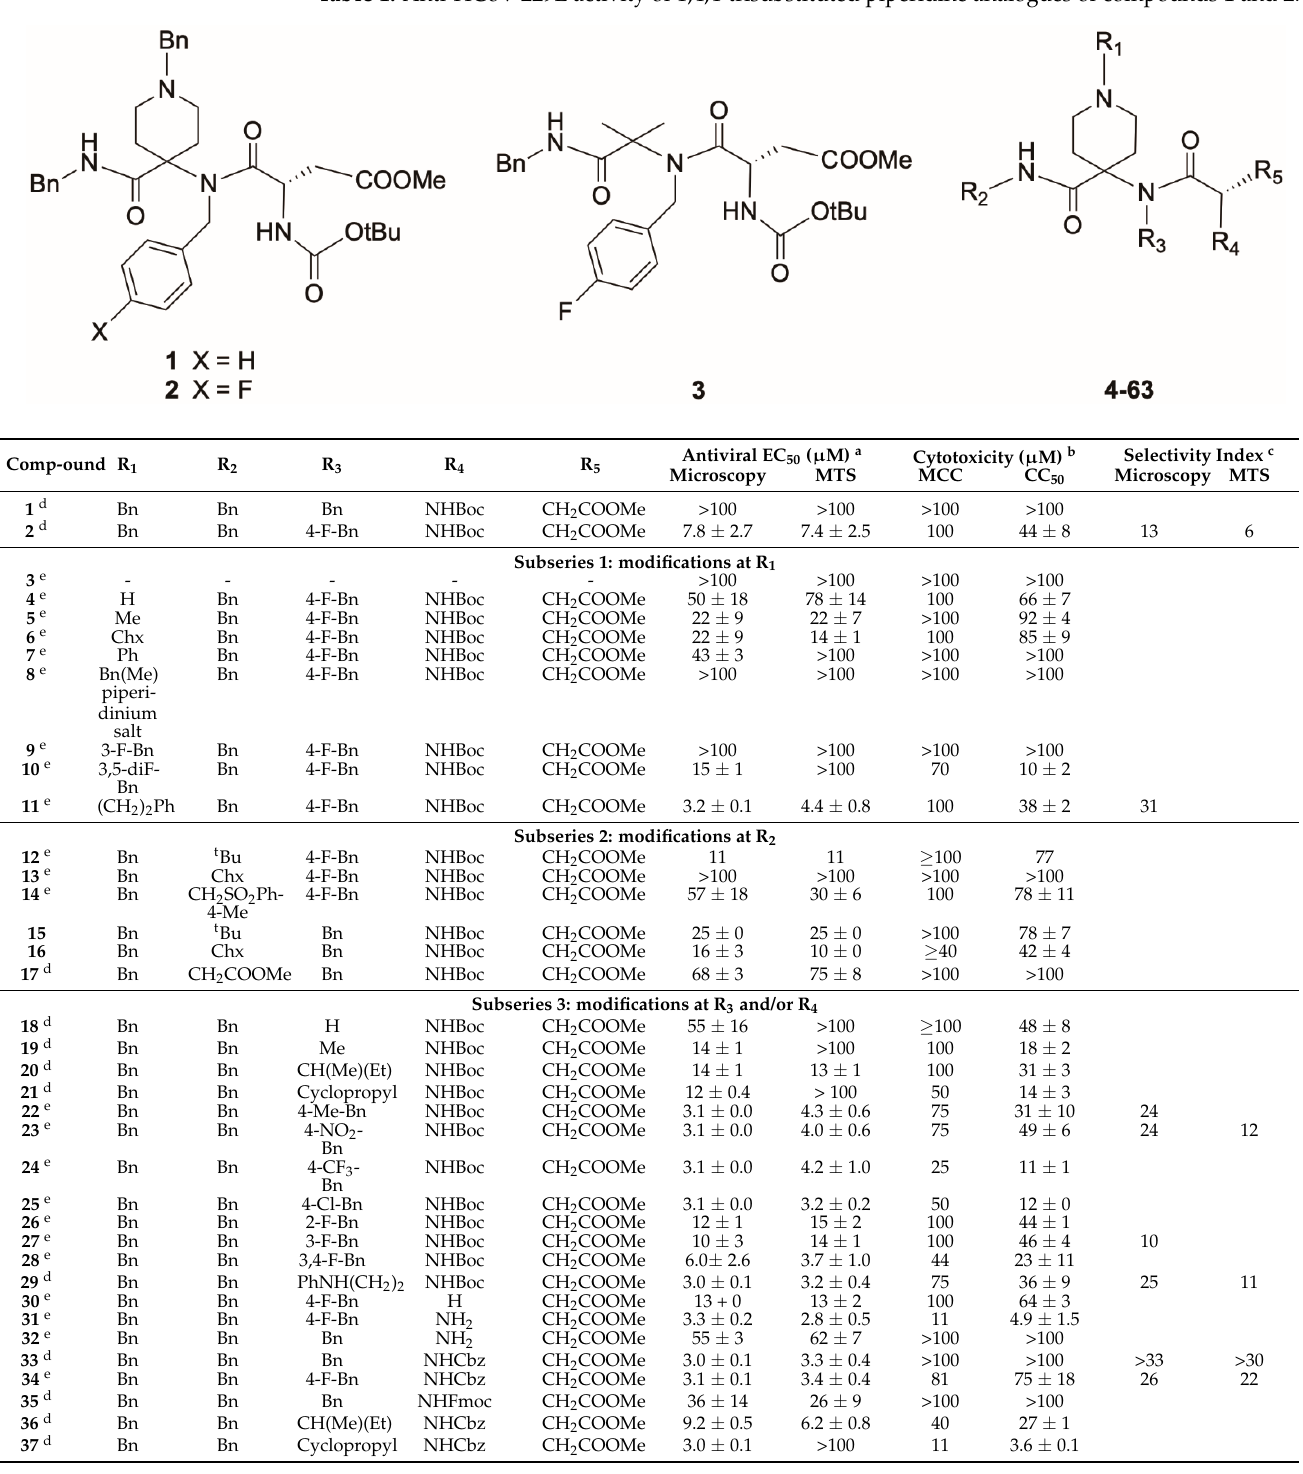
Table 1. Anti-HCoV-229E activity of 1,4,4-trisubstituted piperidine analogues of compounds 1 and 2 .